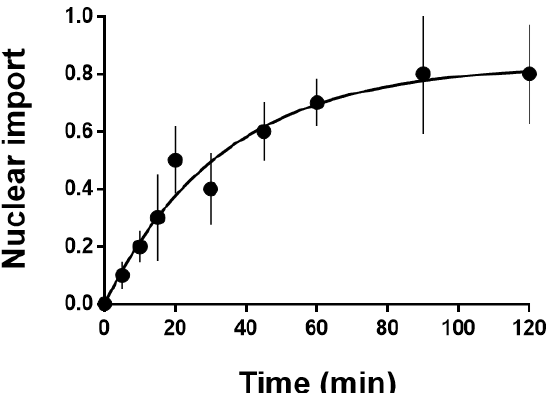
Figure 2. Time-dependent nuclear import of PSTVd after microinjection: fluorescence signals were measured and expressed as relative changes form the initial (baseline) level and then normalized. Data are shown as mean ± standard error (vertical bars). n = 7, 9, 9, 9, 9, 8, 10, 4, and 4 serially from 5 to 120 min. This plot was prepared using a software, Prism 6.0 (GraphPad Software, San Diego, CA, USA).